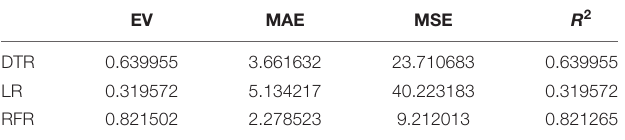
TABLE 2 | Regression index of the openness model.